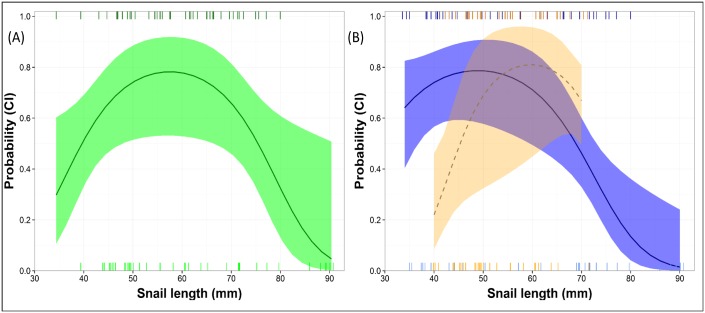
Probability of snail kite foraging selection by snail size.Model predicted foraging preference (with 95% confidence intervals) using only the first choice made during trials. (A) Snail kites showed a high probability of selecting snails between 50 and 65 mm in length. Sizes of snails selected during trials are represented by dark green dashes on top of plot and snails that were not selected are represented by light green dashes on the bottom of the plot. (B) Snail kites in the Kissimmee Chain of Lakes (model prediction is the solid line with blue CI, dark blue dashes represent snail sizes that were selected and light blue dashes represent snails that were not selected) showed a higher relative probability of selecting smaller sized snails (40–55 mm) than those individuals in the Everglades (model prediction is the dash line with orange CI, dark orange dashes represent snails that were selected, light orange dashes represent snails that were not selected).